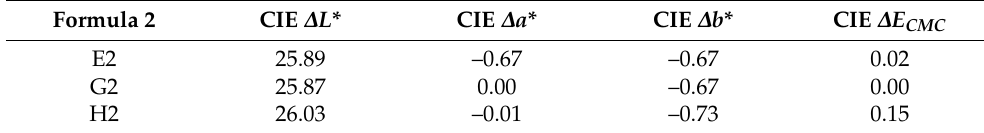
Table 11. The coating color differences of coated panels prepared by Formula 2.